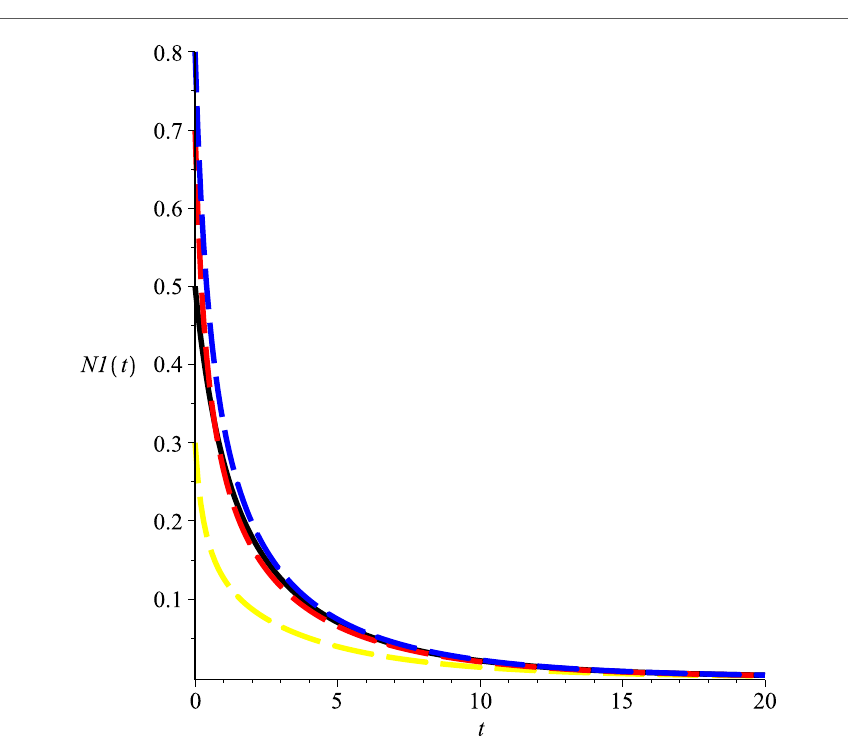
Figure 2 Numeric simulations of the second components of system (5.1) with m = 0, the initial conditions ( x (0), y (0)) = (0.5,0.1),(0.8,1),(0.3,3), and (0.7,2), respectively